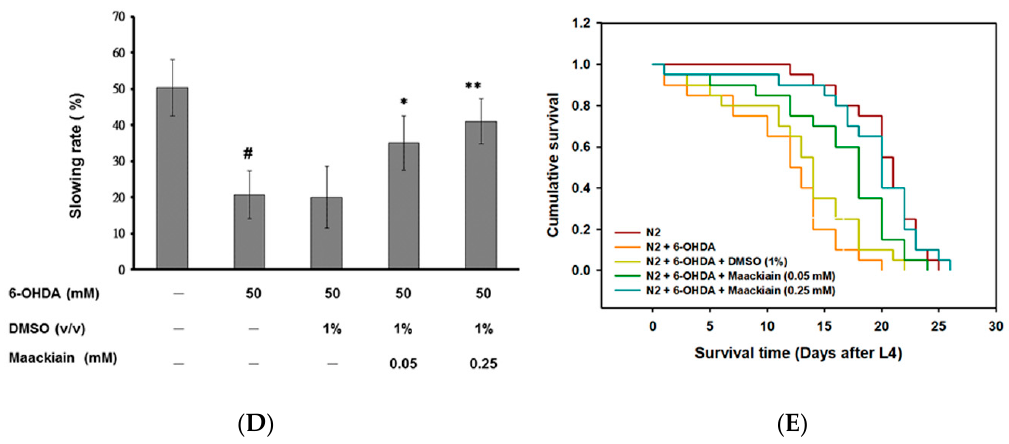
Figure 3. 6 ‐ hydroxydopamine (6 ‐ OHDA) ‐ induced degeneration of dopaminergic (DA) neurons, defects in food ‐ sensing behavior, and shortening of life ‐ span in the BZ555 strain were ameliorated by maackiain (MK) treatment. MK ‐ pretreated or untreated L3 stage BZ555 worms were exposed to 6 ‐ OHDA and then cultured for an additional 3 days. ( A ) Representative fluorescence images of GFP expression in DA neurons. Scale bar = 50 µm. ( B ) Quantifying of GFP fluorescence intensity pattern in 50 animals per group using ImageJ software. ( C ) Degenerative phenotypic defects of DA neurons were scored for 50 animals per group. Data are presented as a percentage of the total population with abnormal phenotypes in each treatment group. ( D ) Slowing rates were calculated as the percentage lessening in frequency of body bending (20 s) in the bacterial lawn compared to without a bacterial lawn for 50 animals per group. ( E ) Cumulative survival curves for worms cultured in OP50/NGM plates until all worms died (50 animals per group). In the above experiments, # shows significant differences between 6 ‐ OHDA ‐ exposed and control worms (# p < 0.001); * shows significant differences between the MK ‐ pretreated 6 ‐ OHDA ‐ exposed and MK ‐ untreated 6 ‐ OHDA ‐ exposed groups (* p < 0.05, ** p < 0.01).